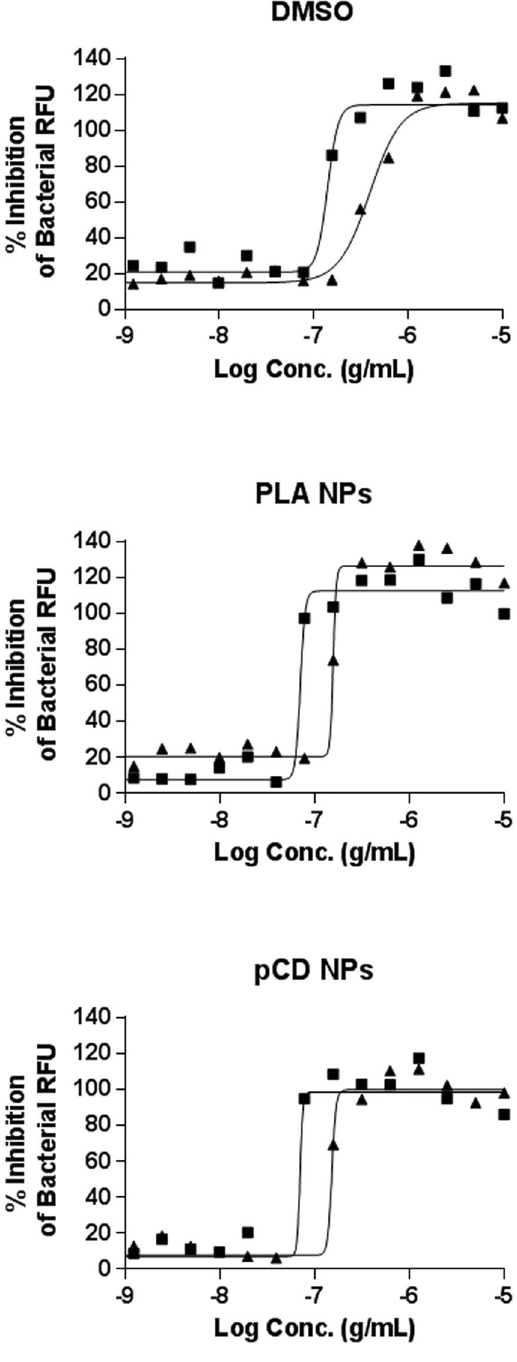
Figure 4. Extracellular antitubercular activity. % of inhibition on bacterial RFU obtained with ETH (solid triangle) and [ETH:Booster] (solid square) in DMSO, PLA NPs and pCD NPs. Data presented correspond to one representative experiment of three